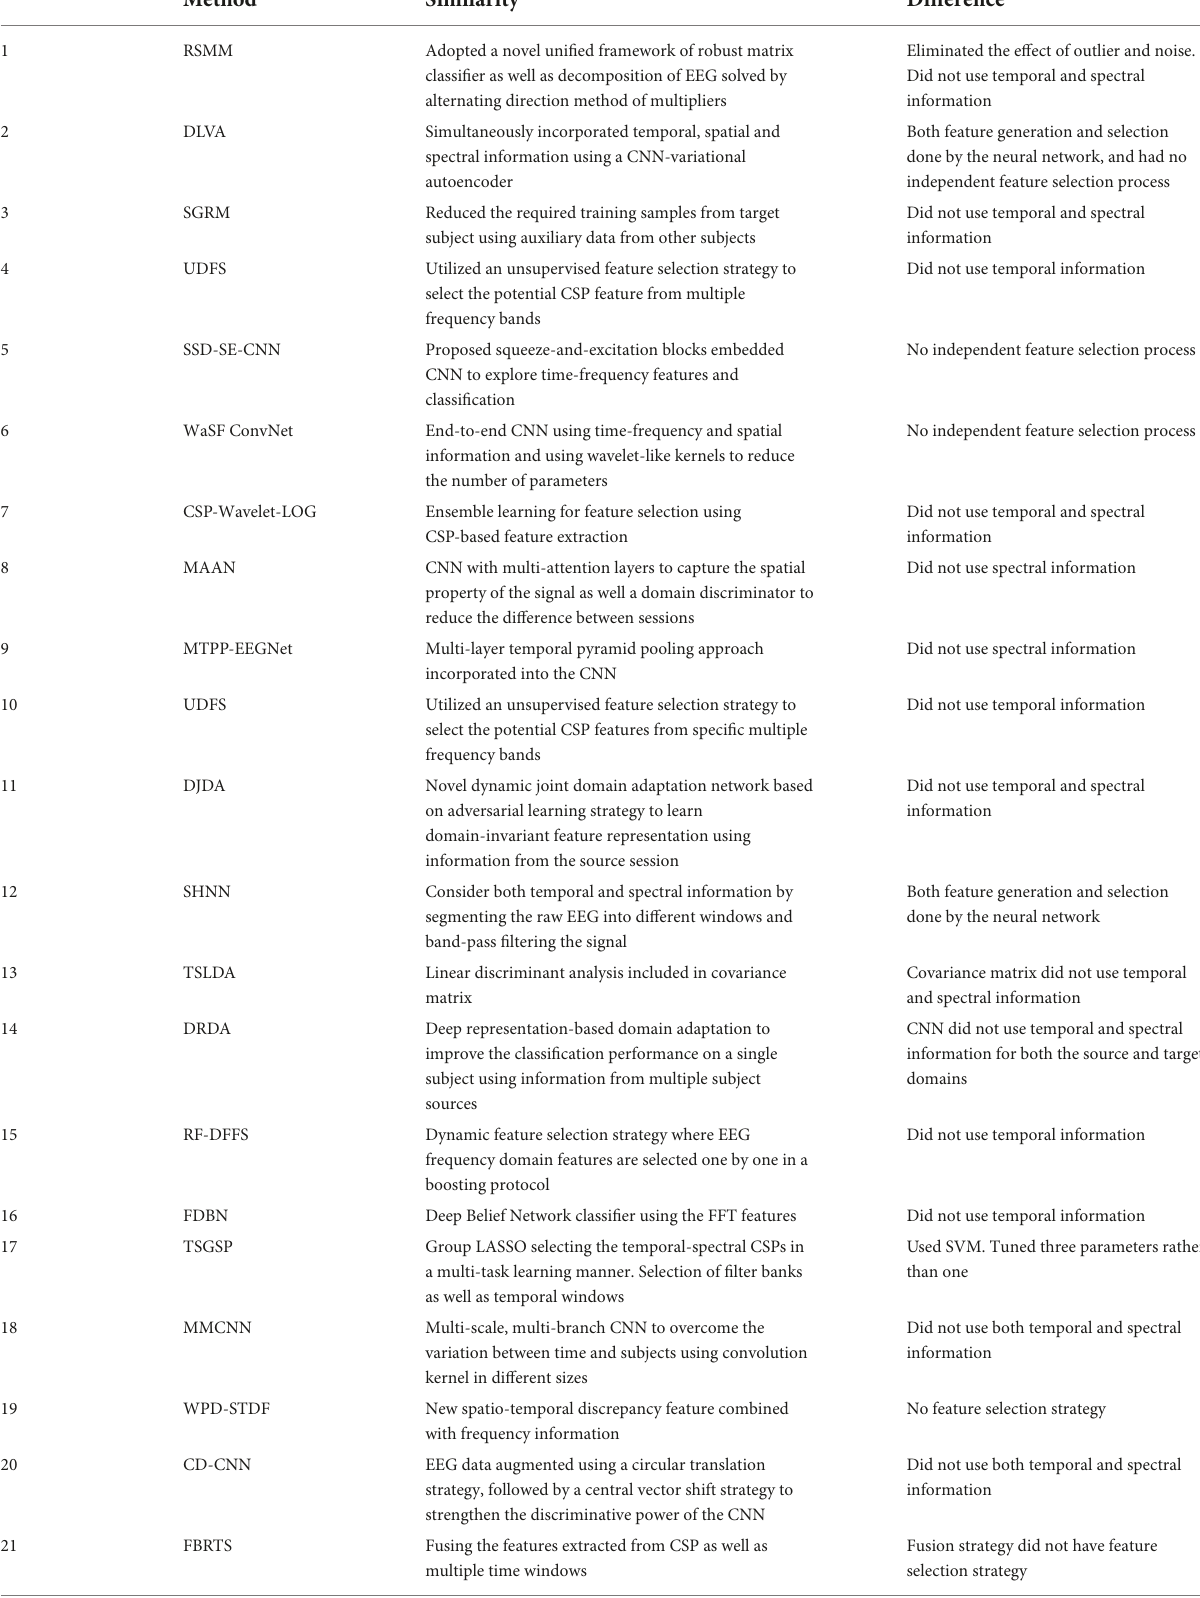
TABLE 11 Comparison of contender algorithm implemented with dataset